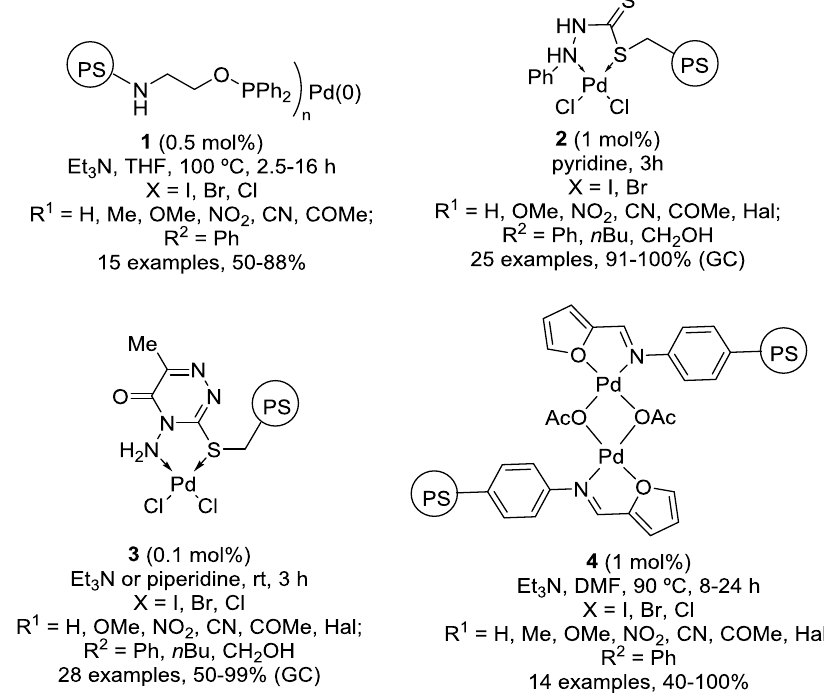
Figure 1. Polystyrene-supported palladium catalysts for the Sonogashira reaction. Conditions, substrate scope and yield range (Scheme 2).